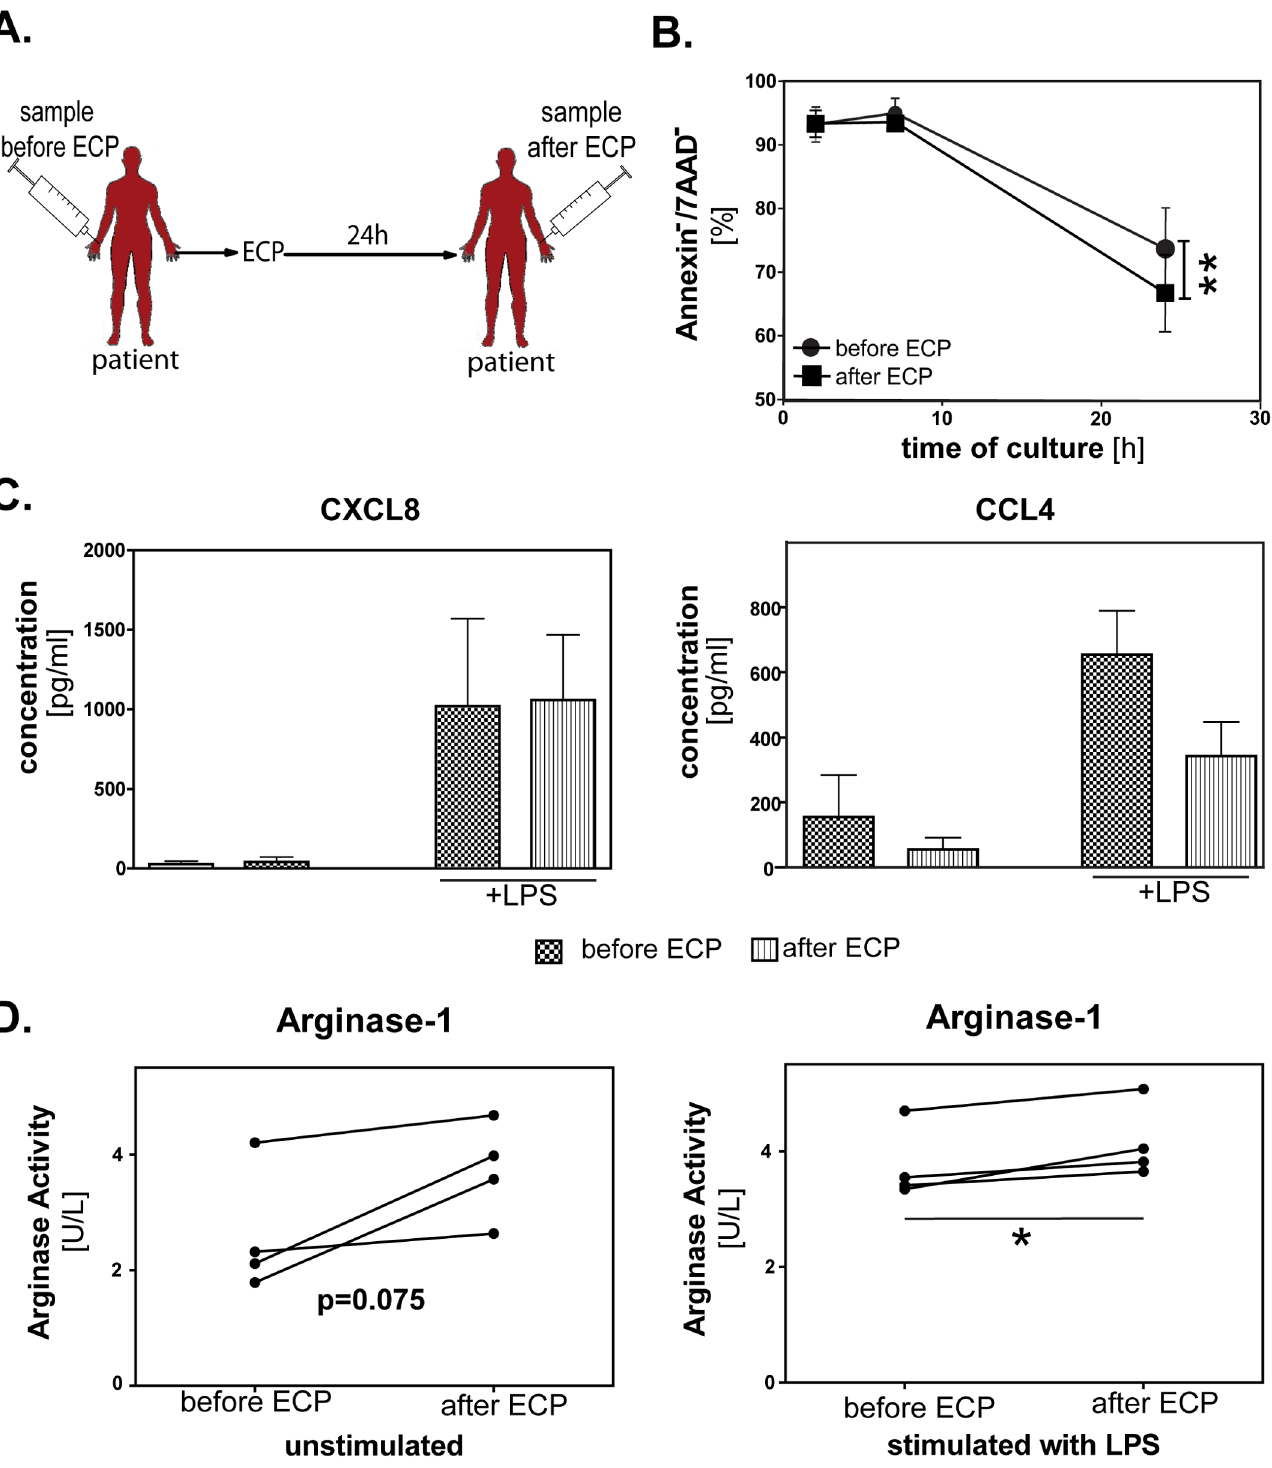
Fig 5. Increased apoptosis and extracellular activity of arginase-1 in neutrophils of cGVHD patients ex vivo after ECP. Analysis was performed in neutrophils from peripheral venous blood of patients with cGVHD. (A) Peripheral venous blood samples of patients with cGVHD were taken prior to and 24h after ECP. (B) Apoptosis of neutrophils isolated from these samples was detected immediately after isolation and after 24h of culture via Annexin-V and 7-AAD staining using flow cytometry (n = 4). Data show means of Annexin - /7-AAD - (viable) cells ± standard deviation (SD). ** p (cid:3) 0.01. (C) Supernatants were generated of the neutrophils described in (A) +/- LPS for 24h and cytokines CXCL8 and CCL4 were quantified by ELISA. Concentrations are shown in pg/ml